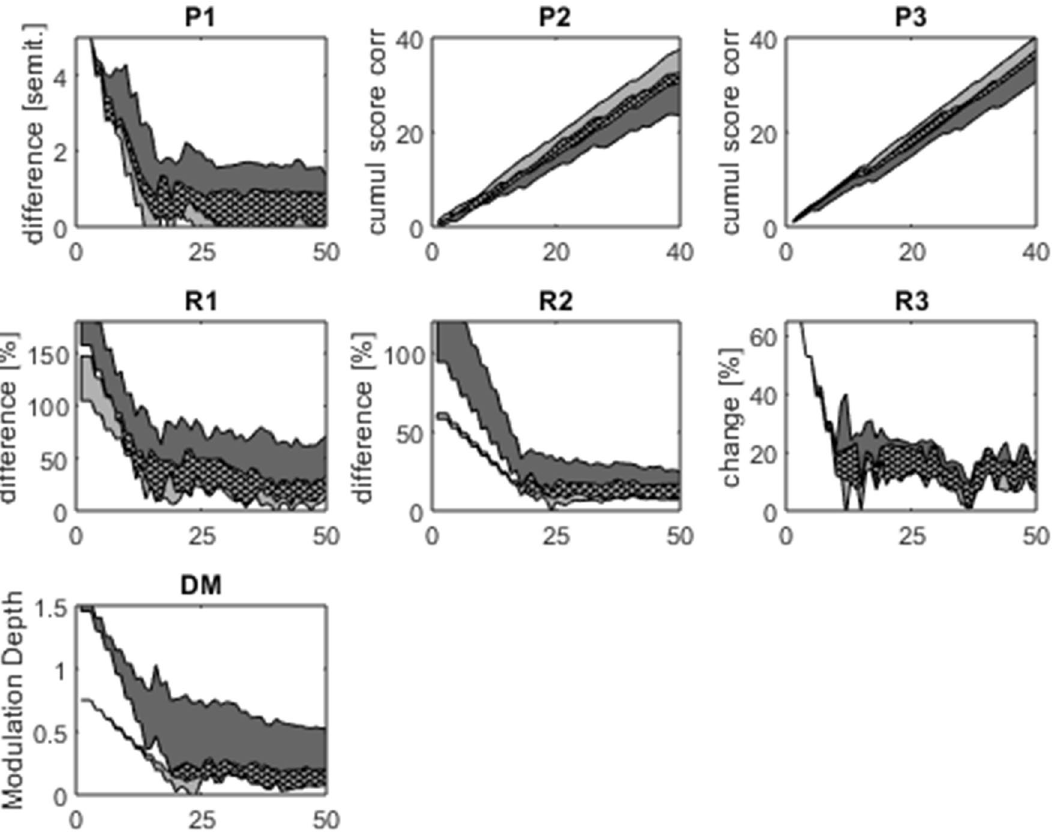
Figure 2. Timecourses for the seven psychoacoustic tests. Each graph shows the timecourse of all participants’ performances throughout one of the seven psychoacoustic tests. X-axes represent trial number. Grey shaded areas represent ± the mean absolute difference from the median performance for all PSA participants (dark grey) and all control participants (light grey); overlap between PSA participants and controls is indicated by crossed-hatch. ‘P1’ = pitch basic change detection; ‘P2’ = pitch detection of local change; ‘P3’ = pitch detection of global change; ‘R1’ = rhythm single time interval discrimination; ‘R2’ = rhythm isochrony deviation detection; ‘R3’ = rhythm metrical pattern discrimination for a strongly metrical sequence; ‘DM’ = Dynamic Modulation detection.